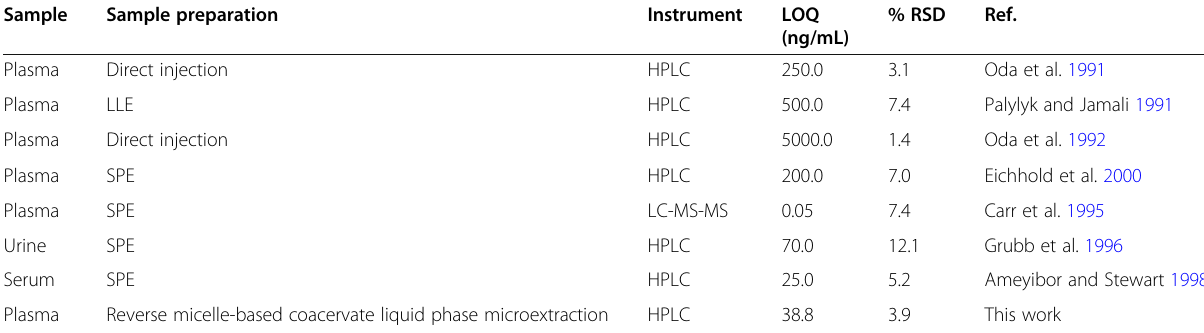
Table 3 Comparison of the developed method with other extraction techniques in literature studies Sample Sample